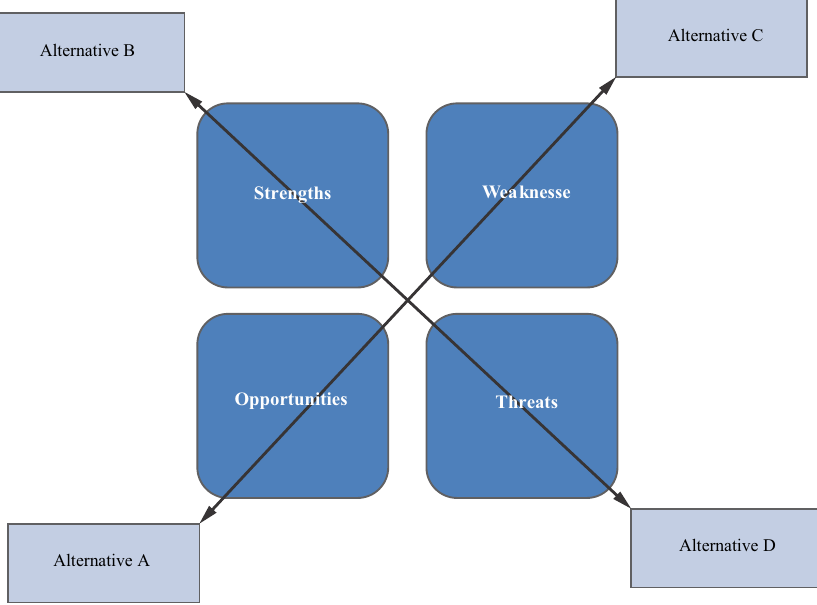
Fig. 4. The adapted TOWS analysis model that is used in